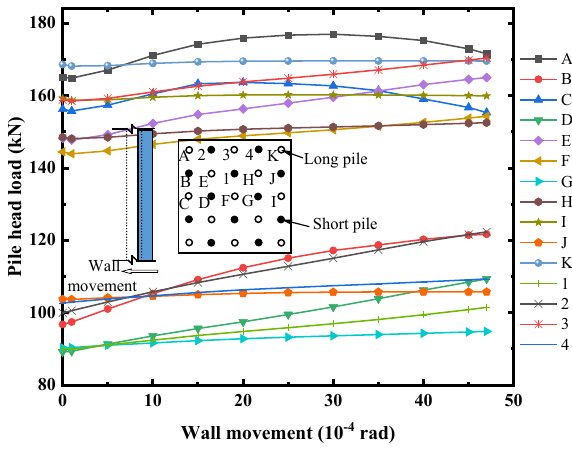
Figure 11: Effect of wall rotation on pile head load in 5 × 5 long-short pile group located at 3 m away from the